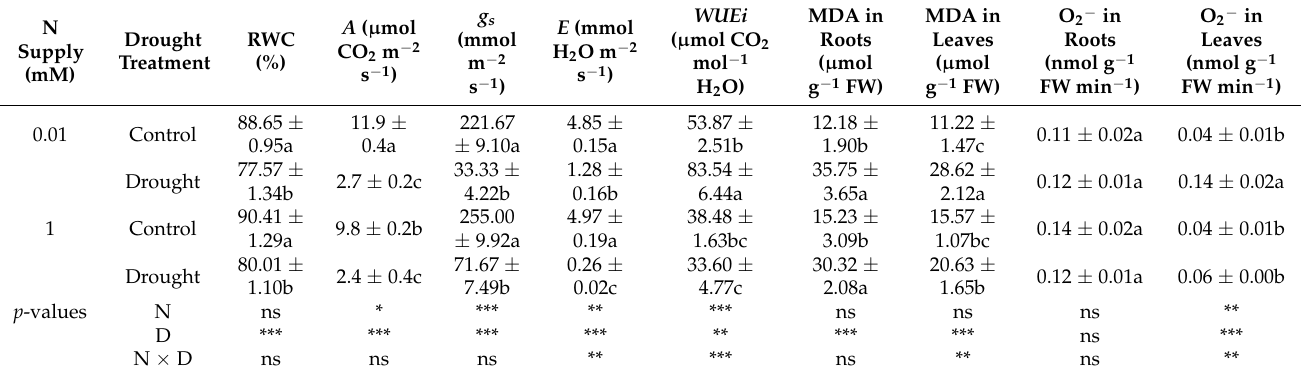
Table 1. The RWC, photosynthesis, MDA, and the rate of O 2 − production of P. simonii as affected by drought and nitrogen